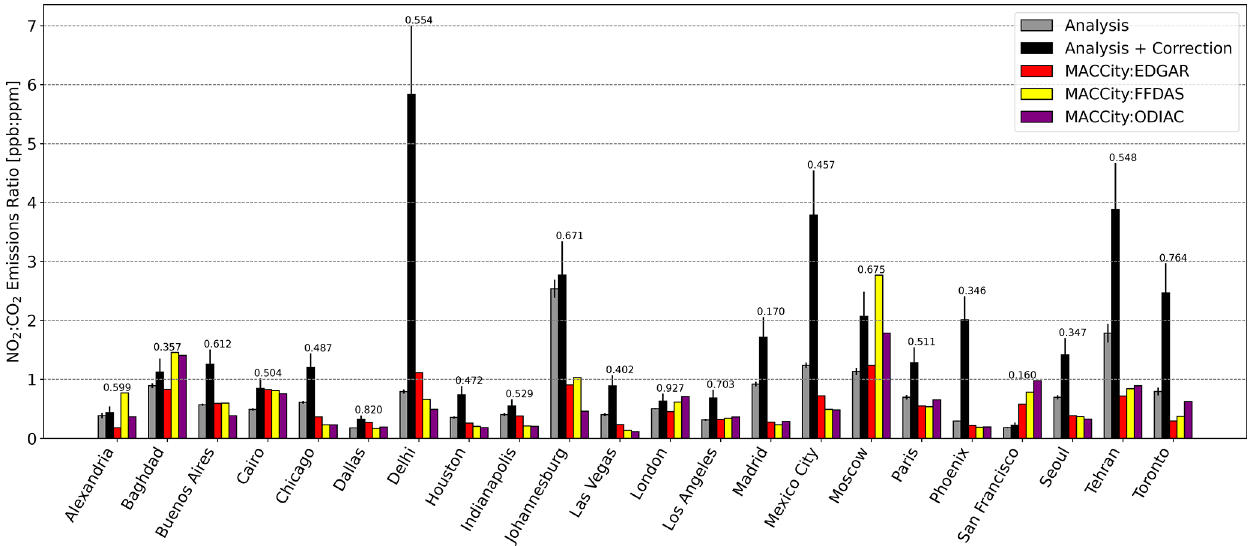
Figure A2. Same as in Fig. 7 but for enhancement ratios calculated using NO x emissions from the MACCity inventory.